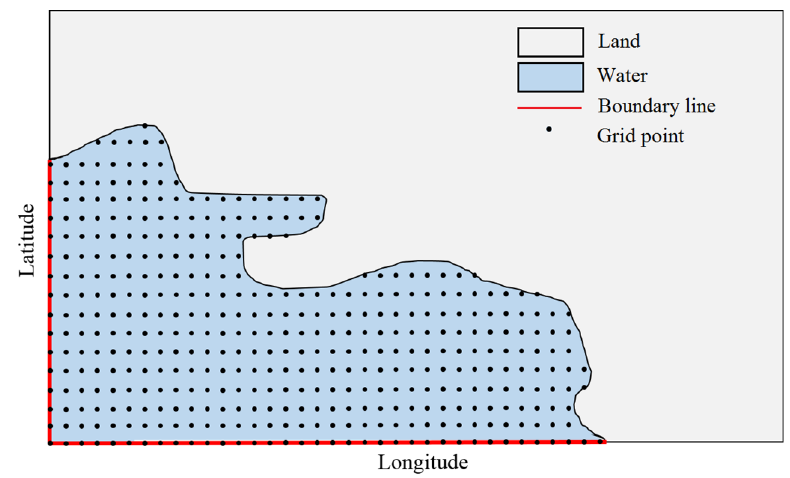
Figure 2. Illustration of the forecast domain.